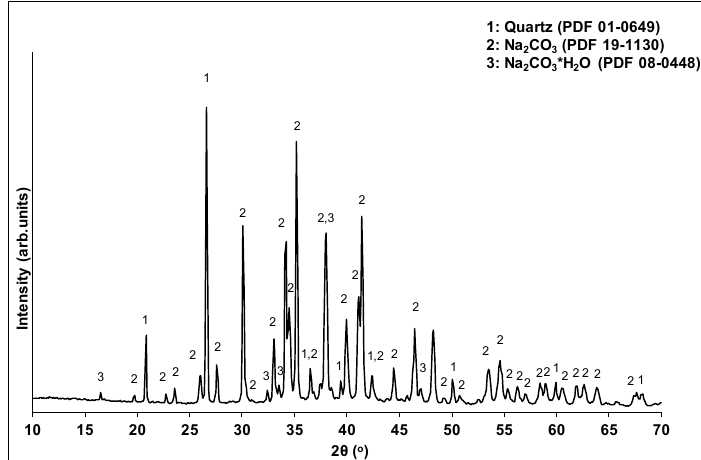
Figure 4. XRD pattern of depositions on the specimens’ surface.